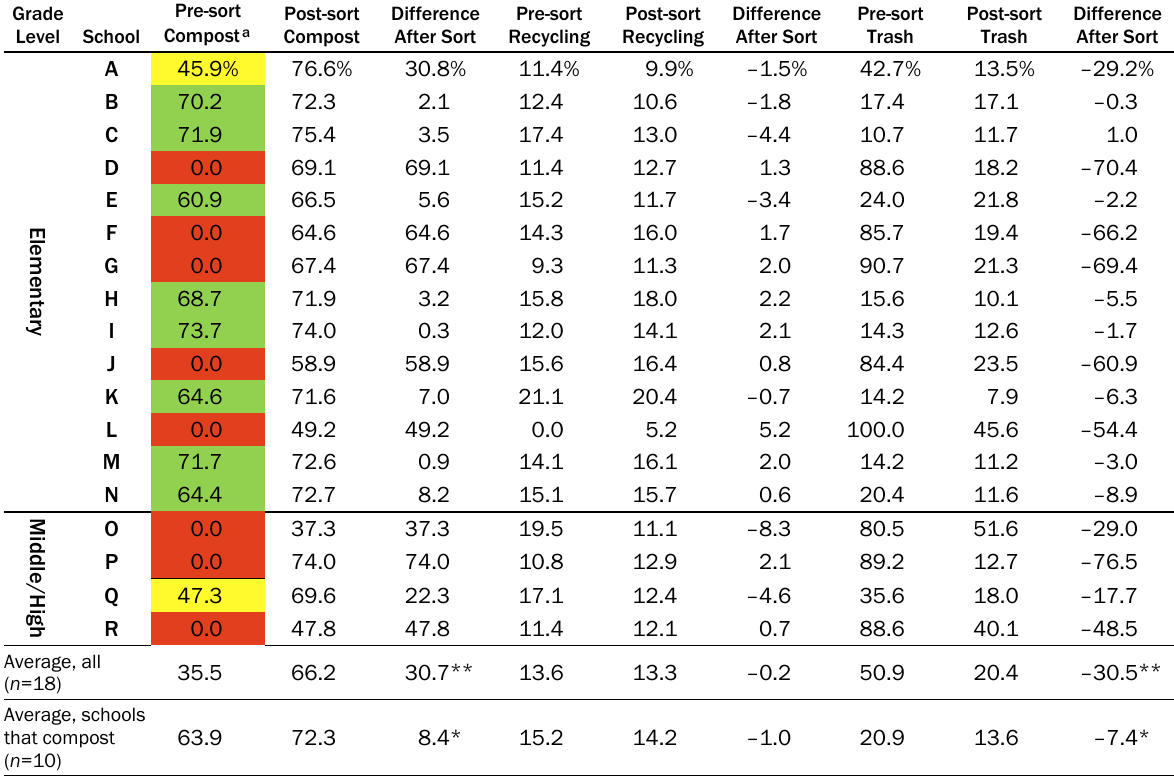
Table 3. School Lunchroom Data on Current Versus Potential Compost, Recycling, and Trash Rates